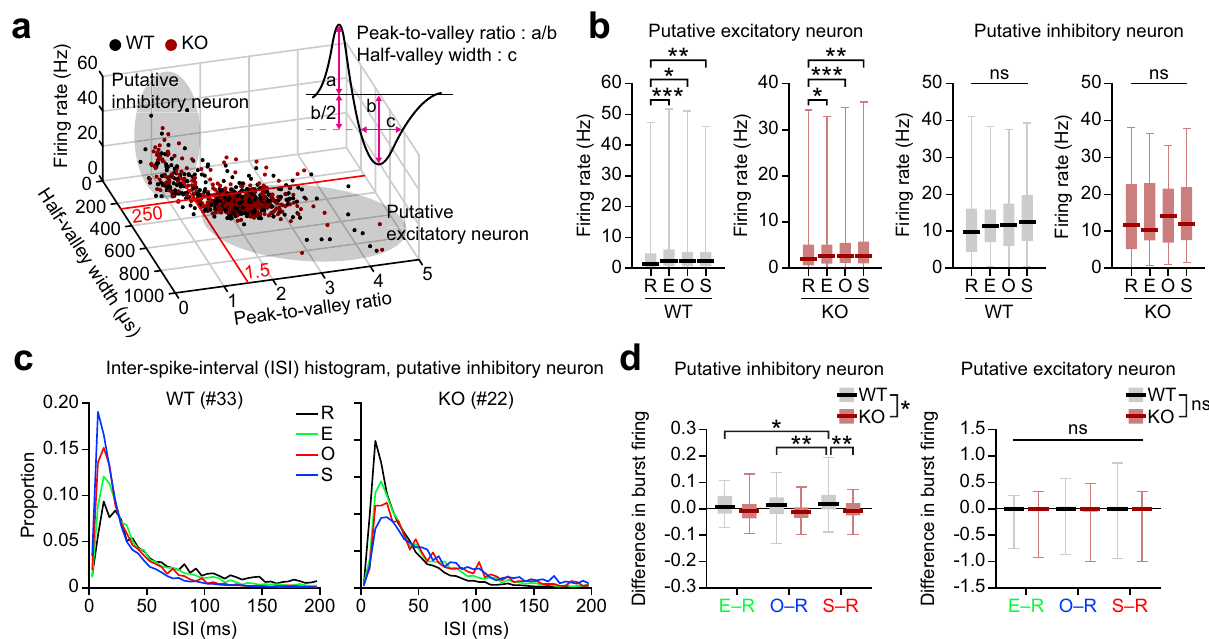
Fig. 2 Impaired burst fi ring in Shank2 – / – mPFC inhibitory neurons. a Classi fi cation of mPFC neurons into putative excitatory and inhibitory neurons. Total neuronal fi rings, grouped into putative excitatory and inhibitory fi rings, based on peak-to-valley ratio and half-valley width. Total spikes from WT (black) and Shank2 – / – (red) mice were plotted three-dimensionally against peak-to-valley ratio, half-valley width, and fi ring rate. Spikes were grouped into putative excitatory and inhibitory fi rings based on peak-to-valley ratio and half-valley width, as follows: excitatory fi rings, peak-to-valley ratio >1.5 and half-valley width >250 µ s; inhibitory fi rings, peak-to-valley ratio <1.5, and half-valley width <250 µ s. b Increased fi ring rates in pExc, but not pInh, neurons upon target encounters, as shown by mean- fi ring rate (±SEM) of pExc and pInh neurons of WT and Shank2 – / – mice in the resting (R) state and with E/O/S encounters ( n = 295 [WT] and 409 [KO], * p < 0.05, ** p < 0.01, *** p < 0.001, Friedman test with Dunn ’ s multiple comparison; p = 0.0005 [R – E], p = 0.0005 [R – O], p = 0.0290 [R – S], p = 0.0072 [WT-pExc], p < 0.0001 [R – E], p = 0.0109 [R – O], p < 0.0001 [R – S], p = 0.0030 [KO-pExc], p = 0.258 [WT-pInh], p = 0.118 [KO-pInh]). c ISI histograms for two sample pInh neurons (left, from WT; right, from KO mouse) in the resting (R) state and with E/O/S encounters. The numbers in the parenthesis indicate single-neuron numbers. d Bar graphs for Δ burst fi ring (changes in high-frequency burst fi rings [<12 ms of ISI] during S/O/E target encounter relative to the R state) for E, O, and S in WT and KO-pInh neurons ( n = 36 [WT] and 41 [KO] for pInh, 286 [WT] and 340 [KO] for pExc, * p < 0.05, ** p < 0.01, two-way repeated-measures/RM-ANOVA with Sidak ’ s multiple comparison test [bar graph]; genotype p = 0.0129, target p